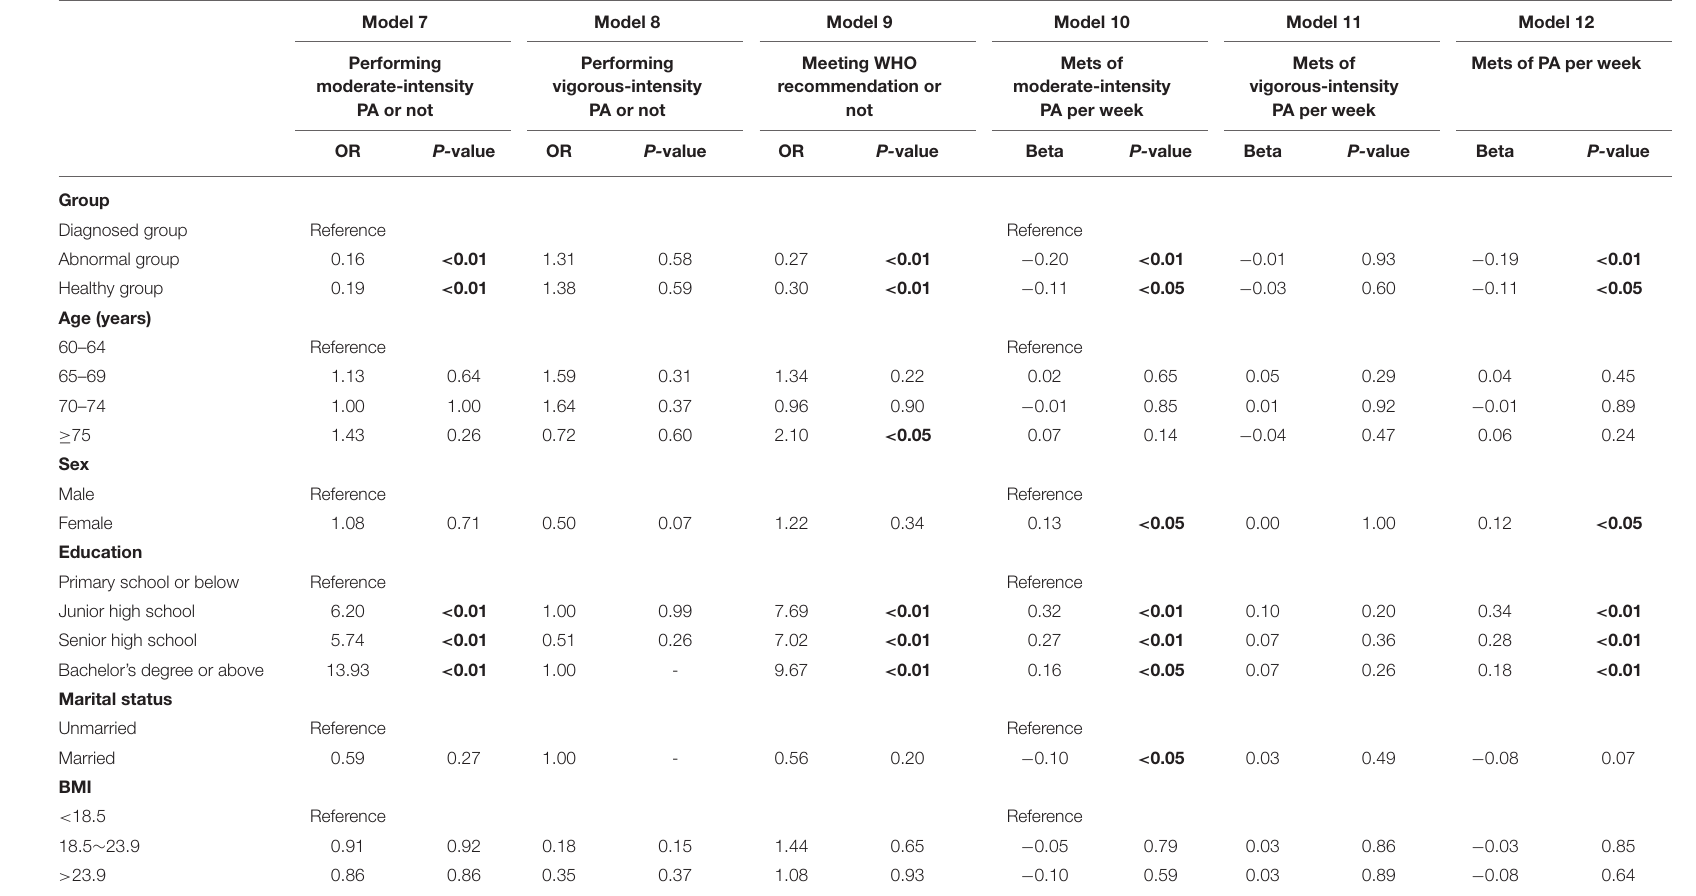
Bold numbers indicate that the differences were statistically